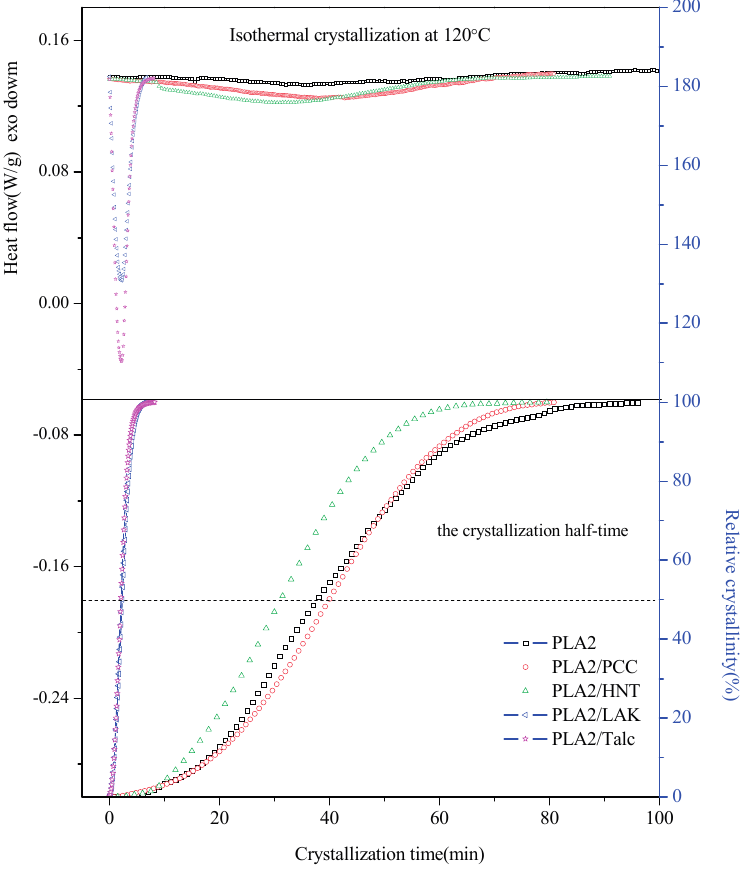
Figure 1. Isothermal crystallization study of PLA2 binary composites with different fillers. (PCC: precipitated calcium carbonate; HNT:halloysite nanotubes; LAK: sulfates).